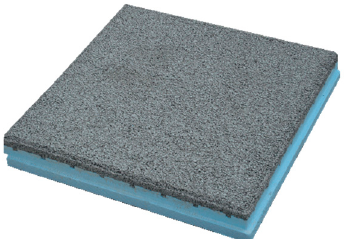
Figure 1. Thermal insulation tiles for flat roofs with an under layer of thermal insulation (extruded polystyrene—XPS) and a cement mortar layer on the top [8].